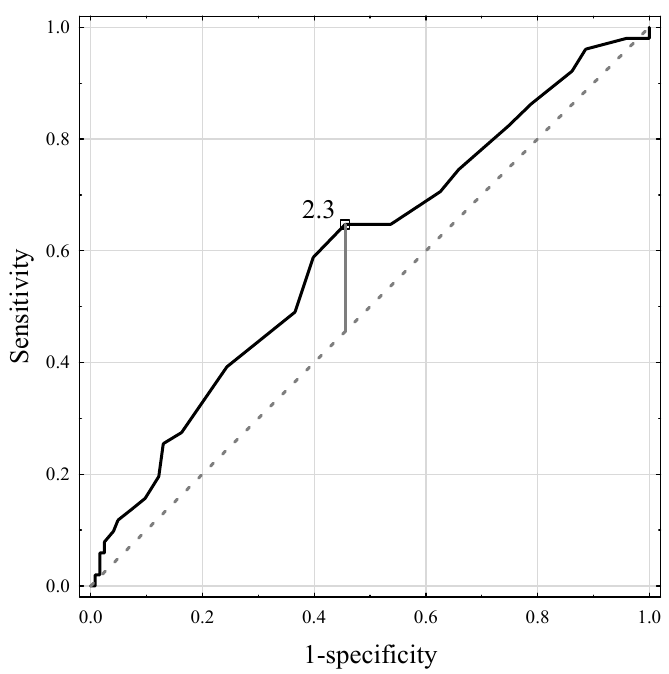
Figure 5. The ROC curve for the skin autofluorescence measurements and liver fibrosis.